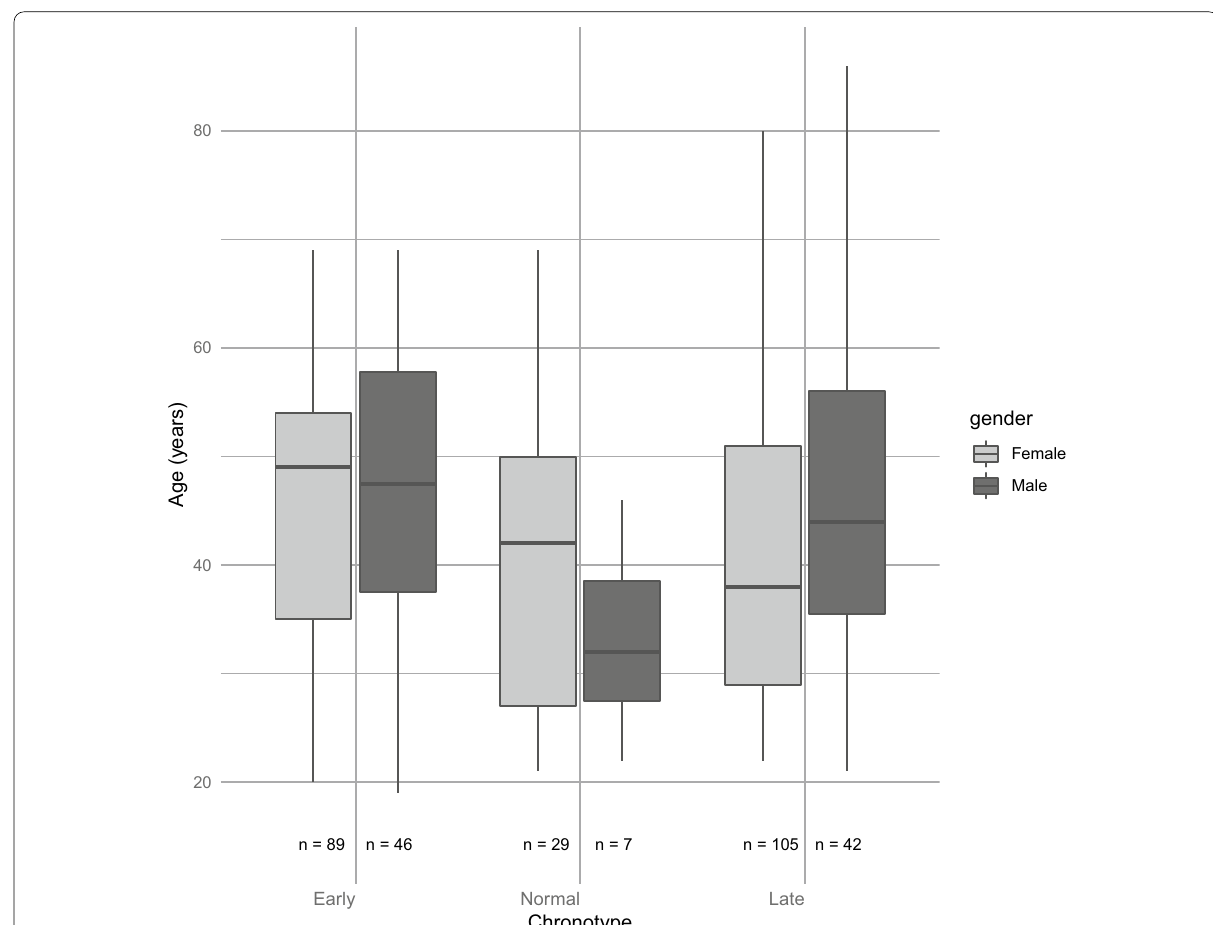
Fig. 1 Boxplots of age is shown for each sex within each of the three chronotypes. The maximum and minimum age is shown by the top and bottom of the vertical lines, the interquartile range is represented by the box, and median by the horizontal line. Compared to early chronotypes, late chronotypes were more likely to be younger and male